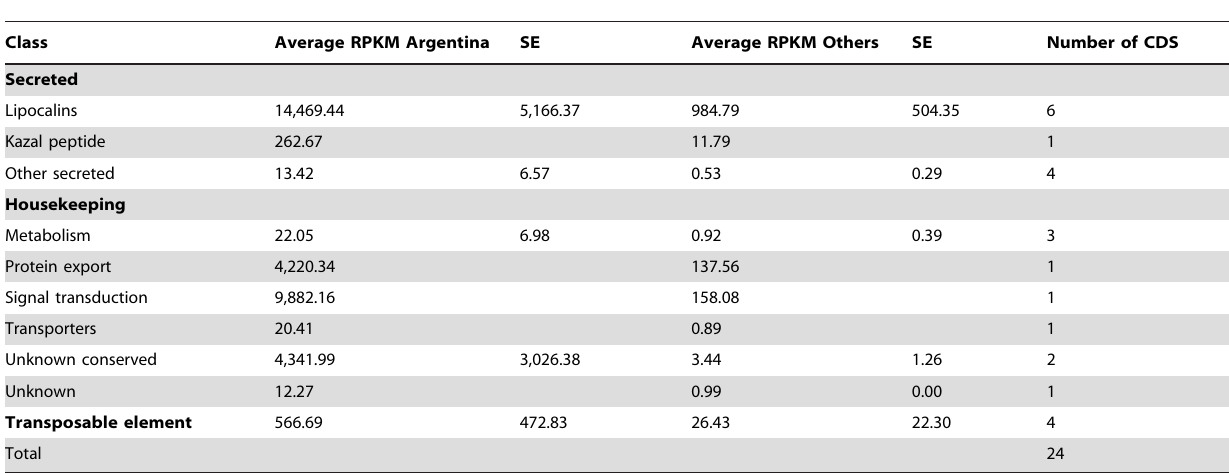
Table 7. Transcripts found overexpressed ( . 10 fold) on Argentinian